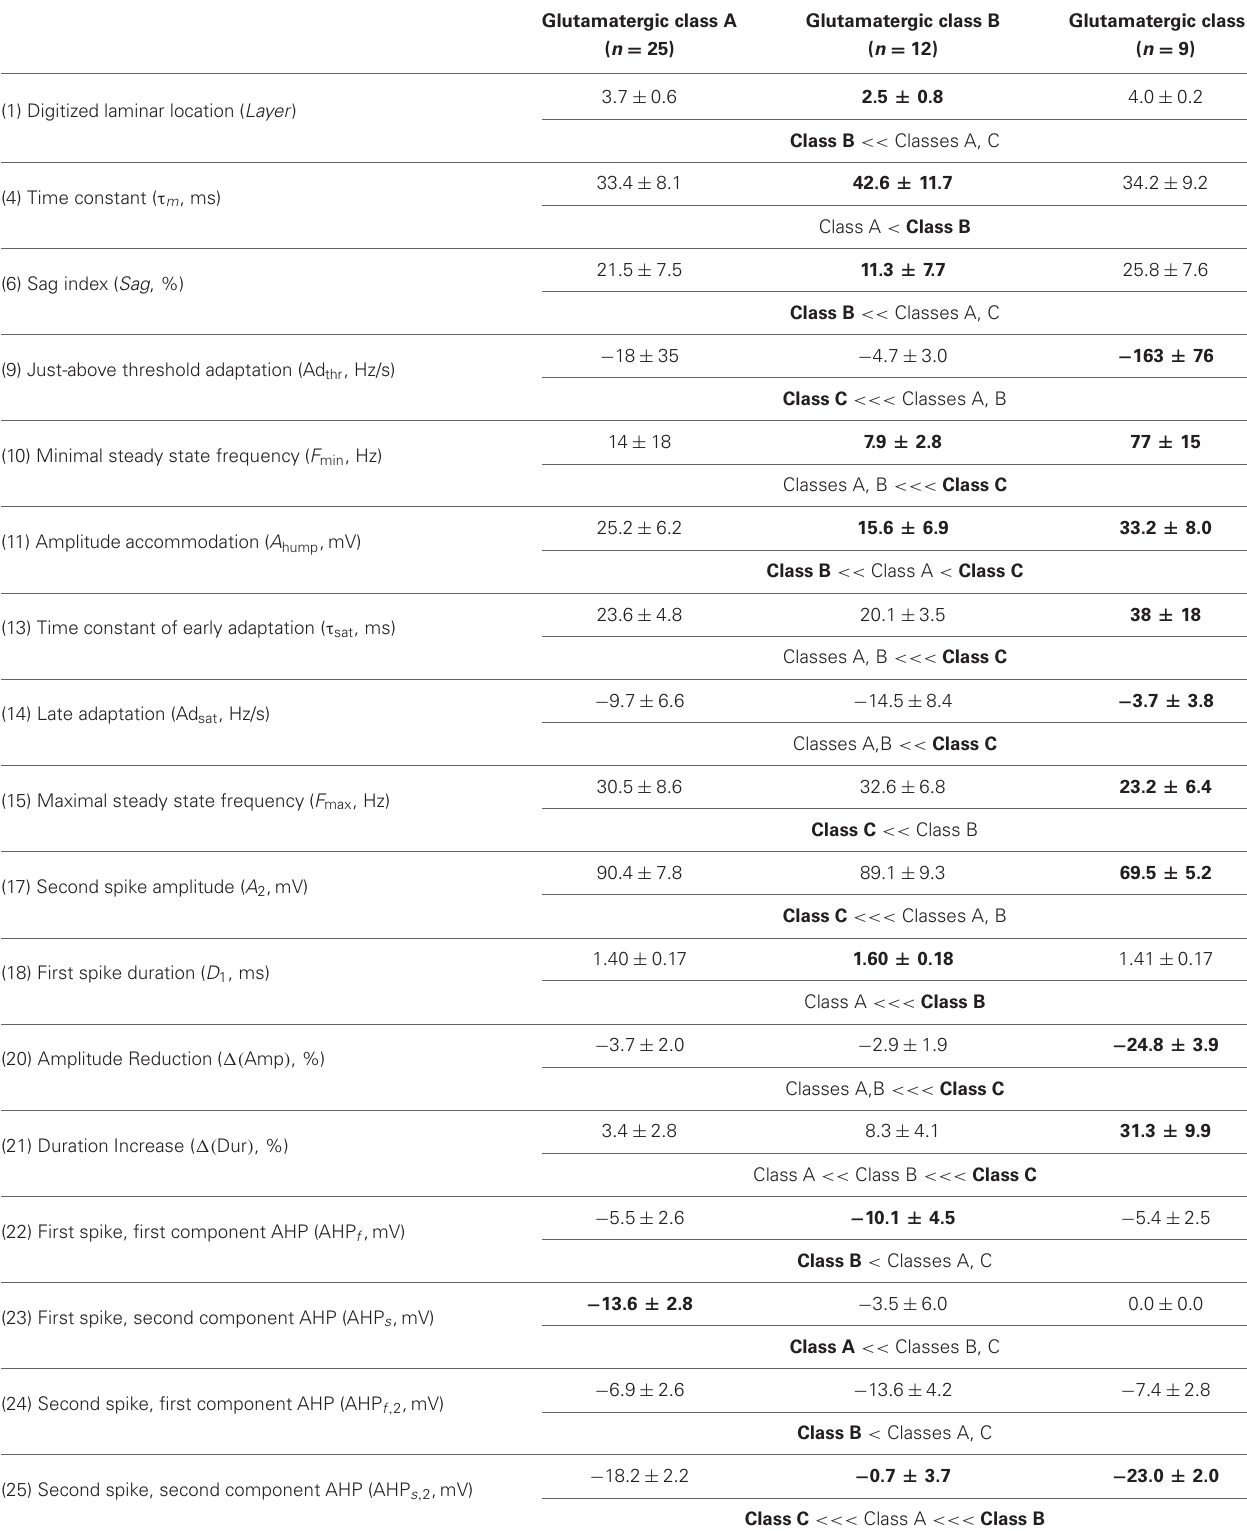
Table 5 | Significant comparisons between glutamatergic